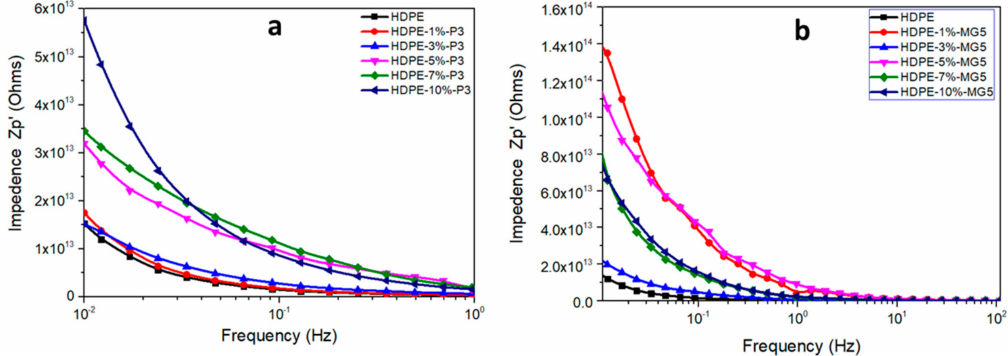
Figure 13. Electrical impedance–frequency relationship of ( a ) HDPE-P3 and ( b ) HDPE-MG5